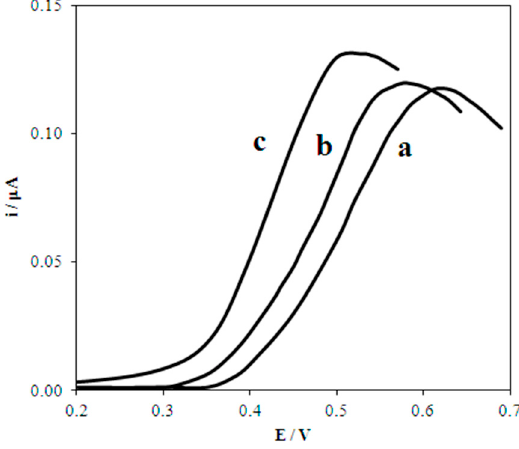
Figure 3. Experimental anodic voltammograms of 0.02 mM UA at GCE ( a ), Au(20nm)/GCE ( b ) and Au(5nm)/GCE ( c ). Background: PBS (pH 7), ν = 50 mV/s. Table 1. Calculated and experimental parameters for voltammograms of UA electrooxidation on macro- and nanostructured electrodes. Calculated No. Electrode